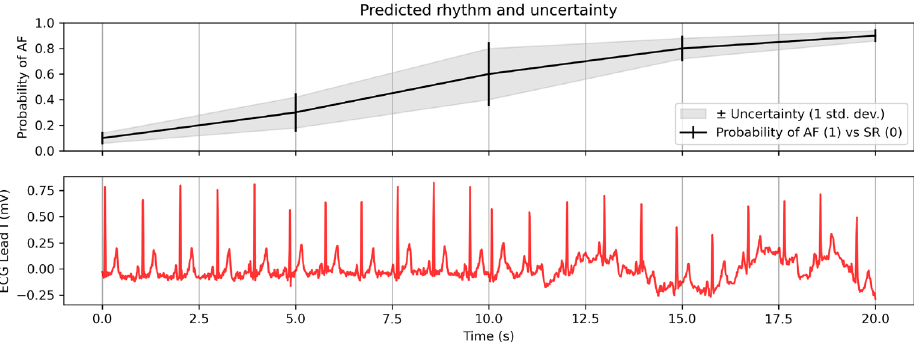
Figure 1. A hypothetical example of how uncertainty estimates can help in interpreting ML model predictions. Here, an AF or sinus rhythm classifier is generating probability estimates for short segments of continuous ECG data. Adding an uncertainty estimate allows us to highlight the transition between different rhythm types, as shown in the raw (unprocessed) signal in red. Depending on the use case, these transition periods could be flagged for further inspection or ignored in favour of less ambiguous time